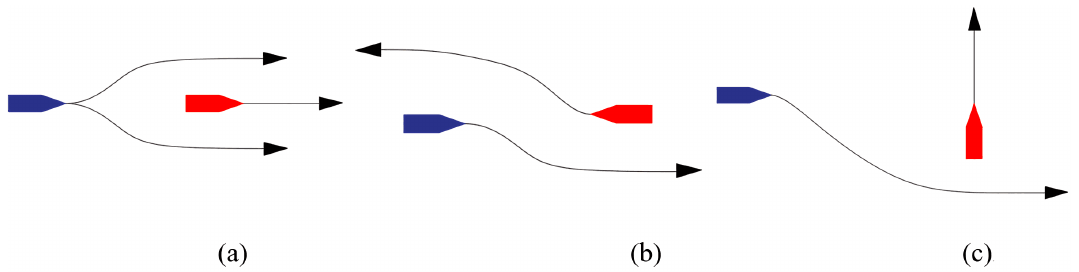
Figure 2. Encounter situations and the avoidance direction for collision avoidance according to COLREGs (blue boat: OS, red boat: TS). ( a ) is overtaking situations; ( b ) is head-on situations; ( c ) is crossing situations.